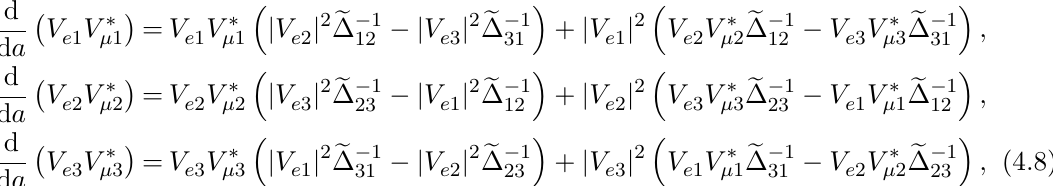
Figure 7 . The evolution of the o(cid:11)-diagonal asymmetries where the same convention and input values as in (cid:12)gure 3 are taken.